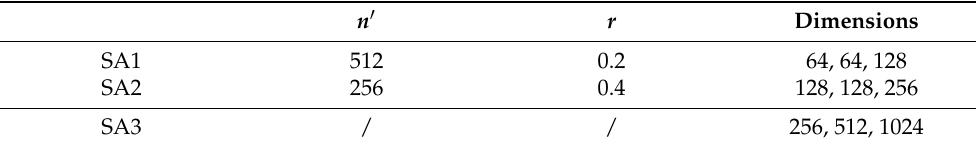
Table 1. Setup of SA ( n (cid:48) : number of output points; r : the radius defining a neighborhood). n (cid:48)